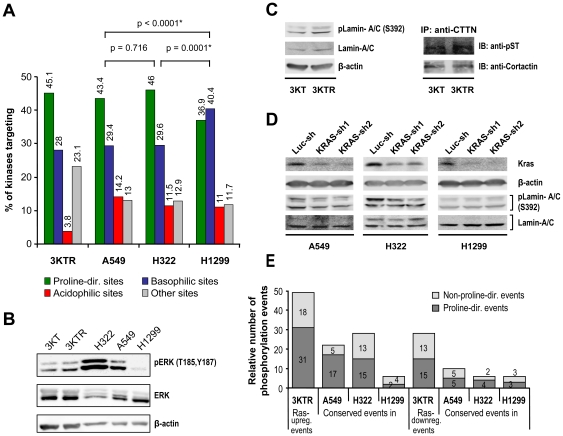
Characterization of the differentially phosphorylated events in Ras-transformed HBECs and NSCLC cells.(A) The kinases targeting regulated phosphosites were derived using NetworKIN analysis. According to their target sequences, the upstream kinases were grouped into subsets of proline-directed, basophilic, acidophilic, and other kinases. Their frequencies are shown for each cell line. (B) Western blot analysis of ERK activation in HBECs and NSCLC cells. (C) Phosphorylation of lamin-A/C and cortactin in HBECs. Western blot analysis was performed to examine the phosphorylation of lamin-A/C at S392 using site-specific antibody. Phosphorylation of cortactin (CTTN) was determined by immunoprecipitation of cortactin in cell lysates using anti-cortactin antibody followed by immunoblot analysis using antibody specific for phosphorylated Ser/Thr. (D) Western blot analysis of lamin-A/C phosphorylation in KRAS knockdown NSCLC cell lines. Lung cancer A549, H322 and H1299 cells were infected with Lentivirus harboring shRNAs targeting at luciferase or KRAS overnight. Two individual shRNAs targeting at KRAS were employed. Cells were grown in serum-free medium for an additional 24 hrs prior to western blot analysis of designated proteins. The status of lamin-A/C pS392 was detected by site-specific antibody. β-actin was used as protein loading control. (E) Ras-regulated phosphorylation events observed in Ras-transformed HBECs and NSCLC cells. The Ras-regulated phosphorylation events, including 49 upregulated and 28 downregulated events, identified in Ras-transformed HBECs were classified as proline-directed and non-proline-directed phosphosites according to their consensus sequences. The conservation of Ras-regulated phosphorylation events in NSCLC A549, H322, and H1299 cells is shown.